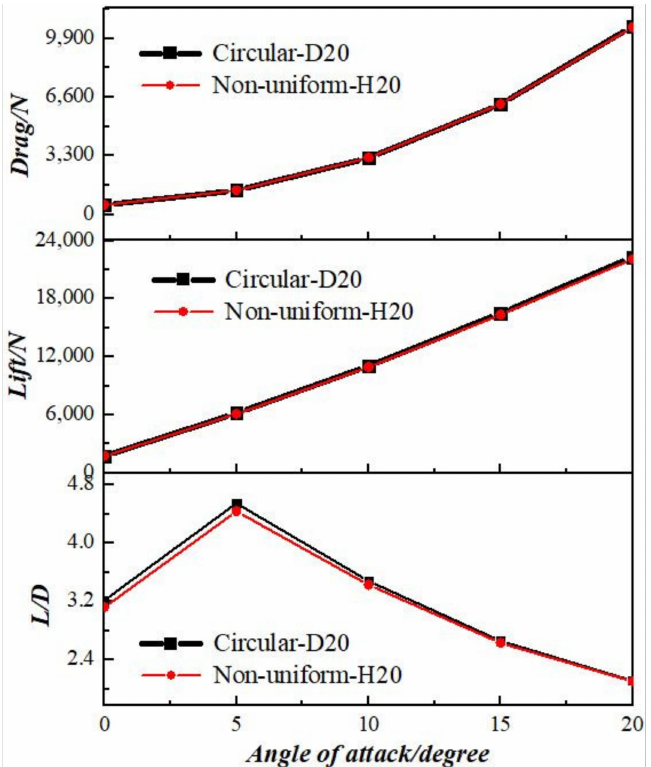
Figure 16. Aerodynamic performance of different blunt profiles with angle of attack (diameter/height: 20